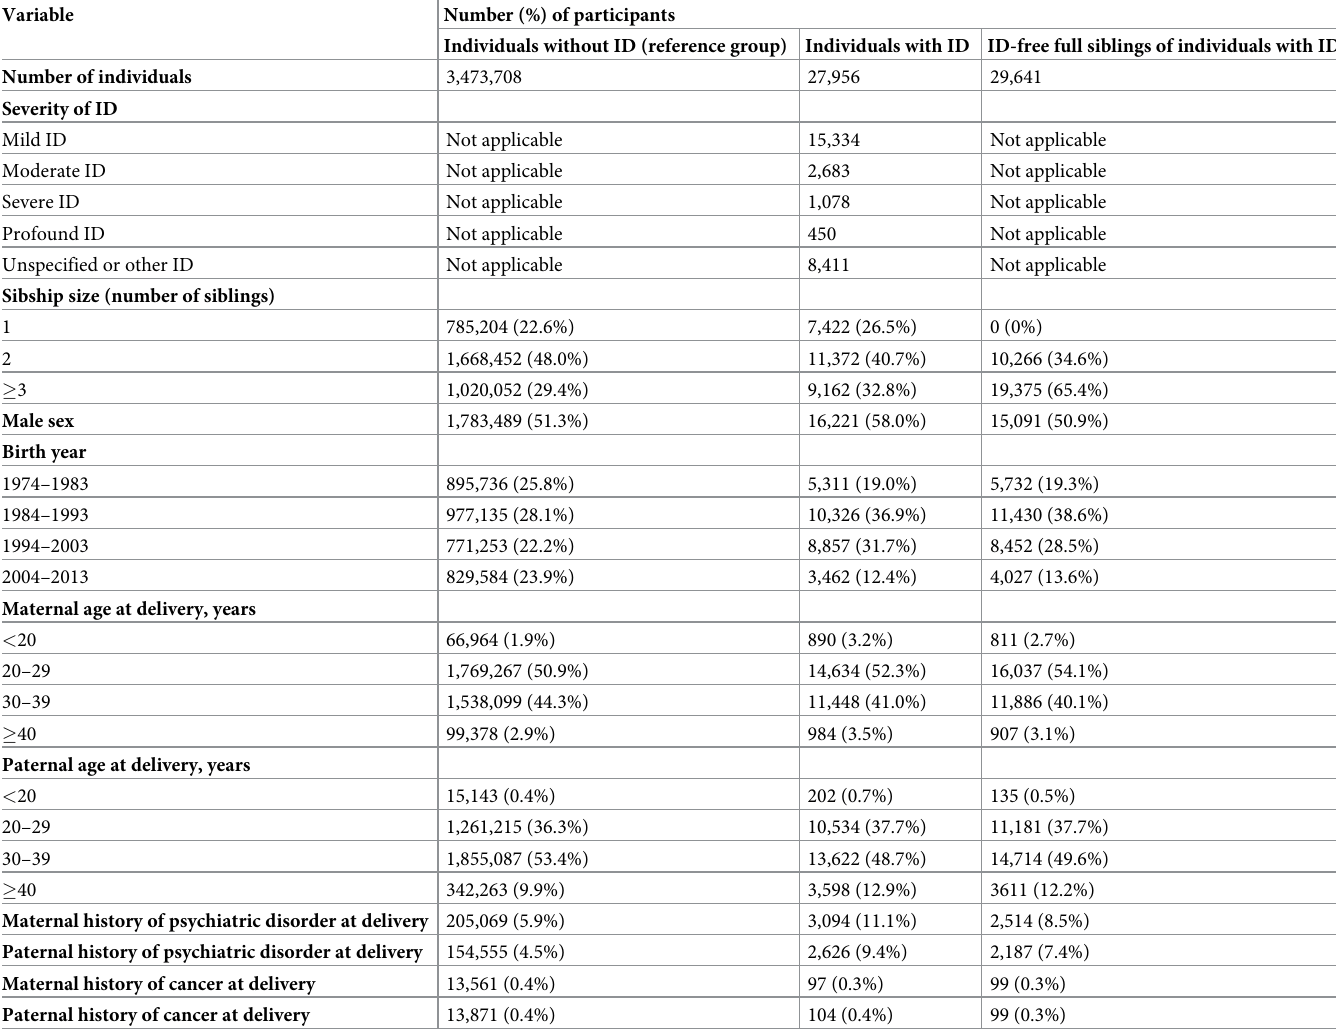
Table 1. Characteristics of the cohort